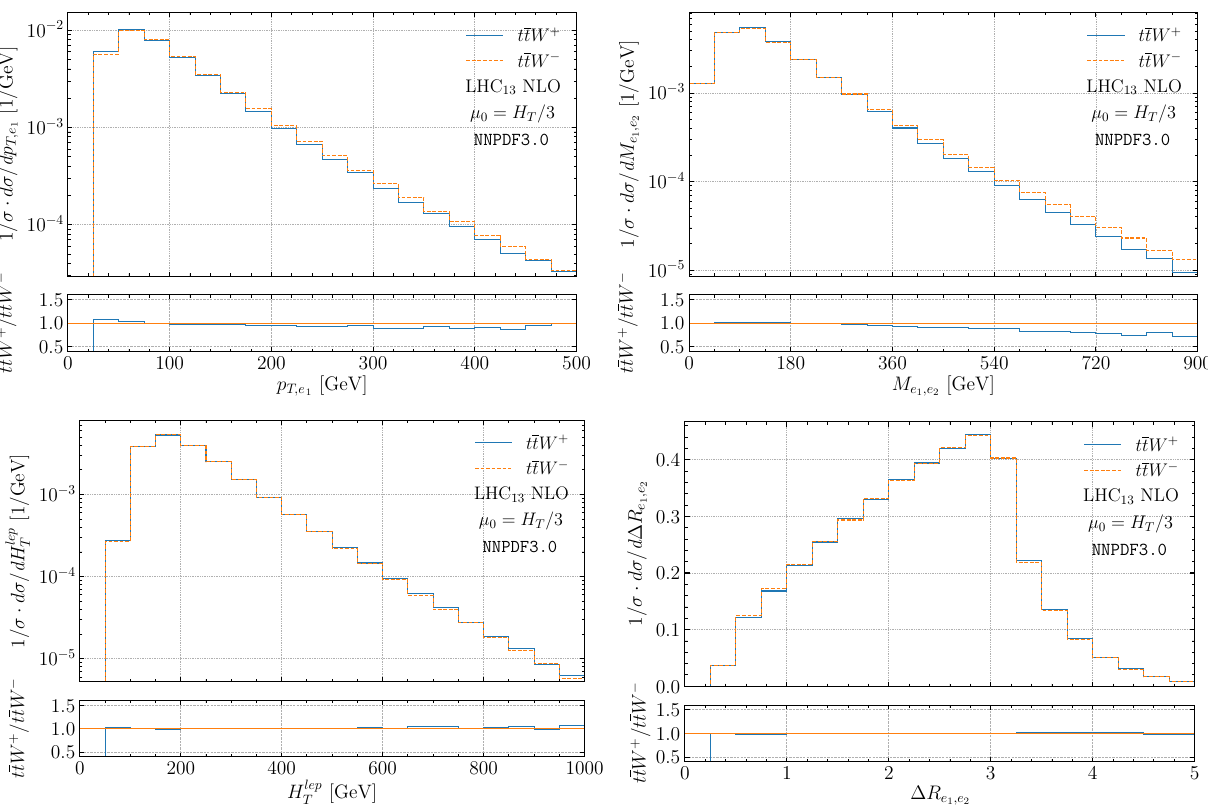
) and the distance in the azimuthal angle rapidity of the leptons ( H lep T ) . The lower panels plane between the two same-sign leptons ((cid:12) R e 1 e 2 displaytheratioofthenormaliseddistributions t ¯ tW + / t ¯ tW − .TheNLO ) NNPDF3.0 PDF set is employed and μ R = μ F = H T / 3 is e 1 e 2